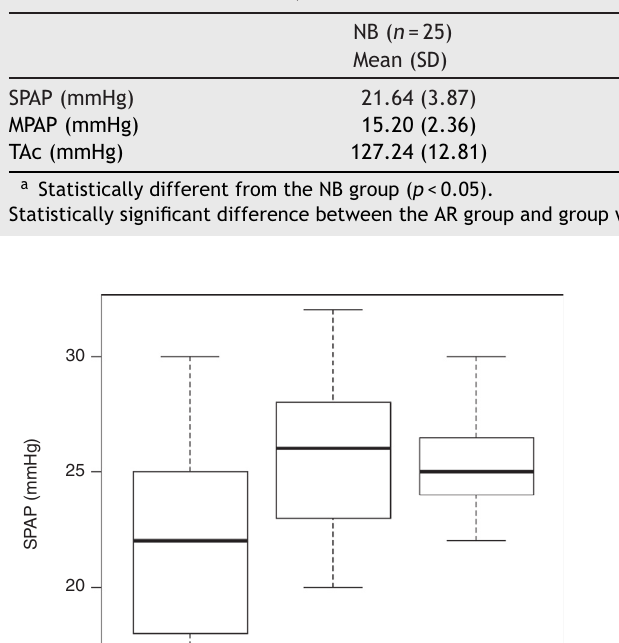
Mean values of SPAP, MPAP and TAc.